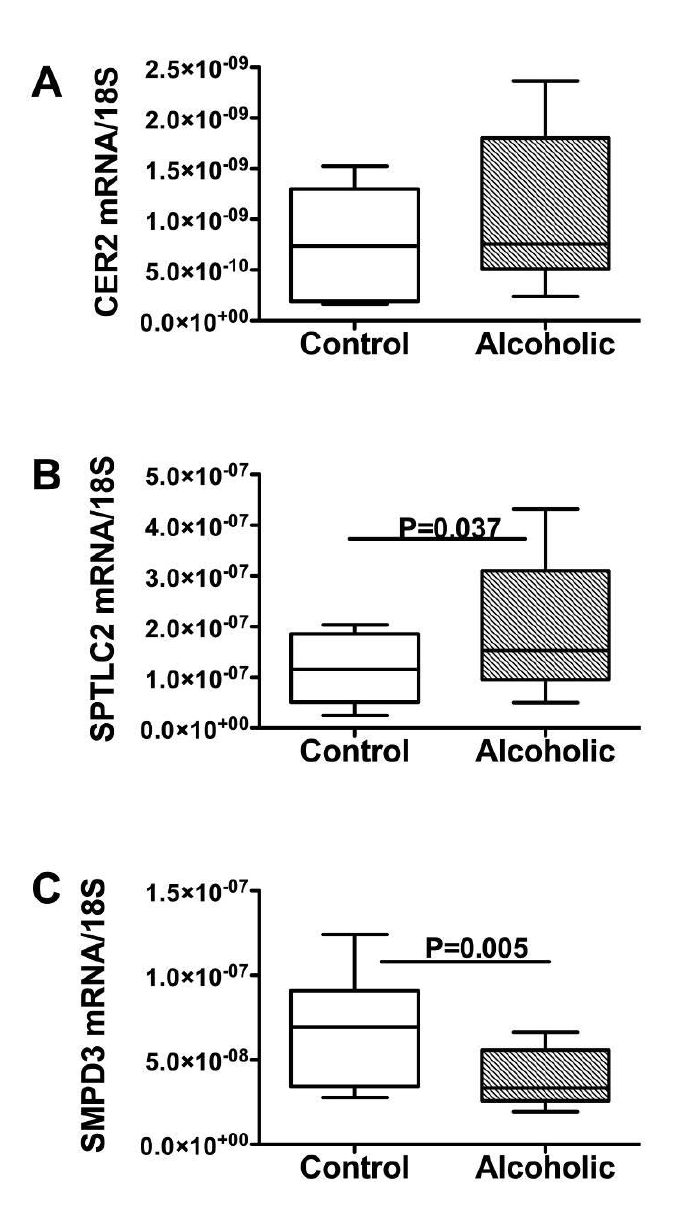
Figure 6. Pro-ceramide gene expression in human controls and chronic alcoholic brains as measured by qRT-PCR analysis. RNA was isolated from frontal lobes of postmortem brains and used to measure (A) ceramide synthase 2 (CER2), (B) SPTLC2, and (C) Sphingomyelinase 3 (SMPD3). Results were normalize to 18S rRNA. Significant P-values are shown over the bars. CER2 and SPTLC2 generate ceramide via a biosynthetic pathway. SPMD3 produces ceramides and other toxic lipids via a degradation pathway